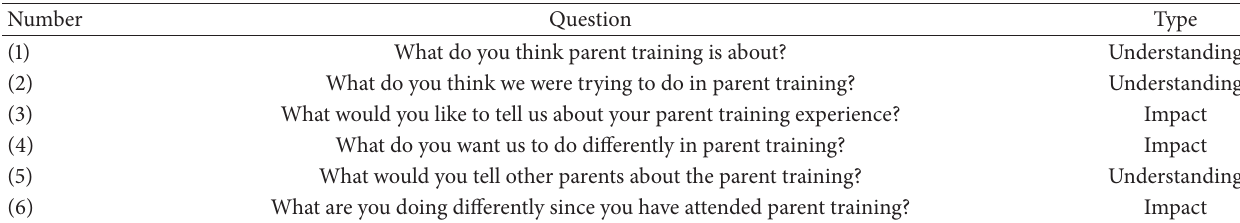
Table 1: Open-ended Interview Questions.